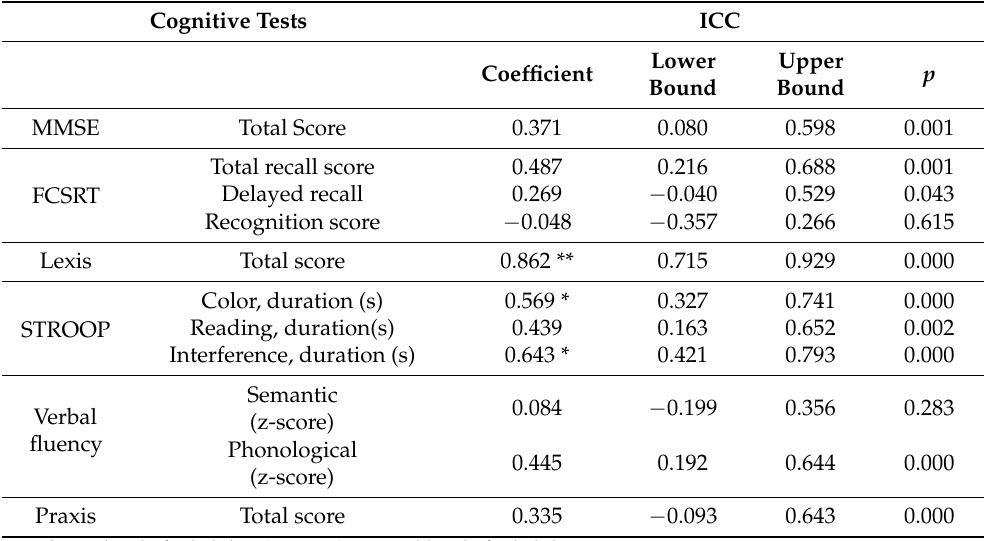
Table 4. Intraclass Coefficient Correlation results between FTF and TNP cognitive test scores.